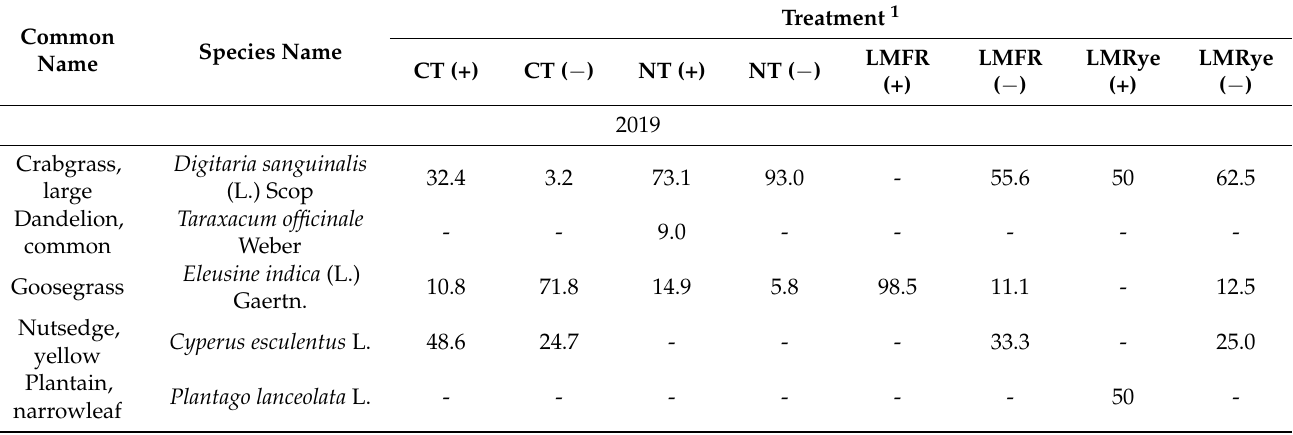
Table 2. Percent of abundance of all weed species making up >5% total abundance.